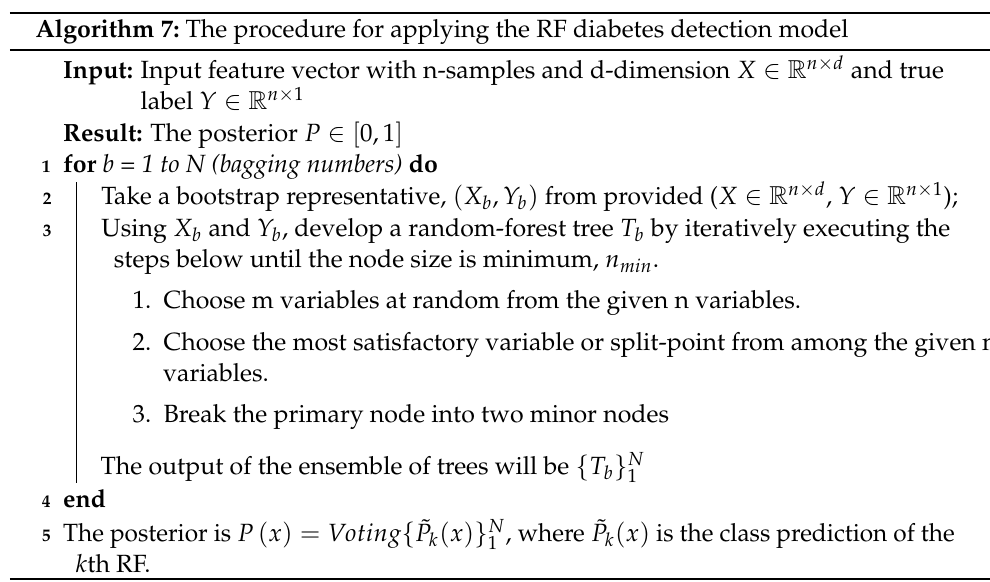
Algorithm 7: The procedure for applying the RF diabetes detection